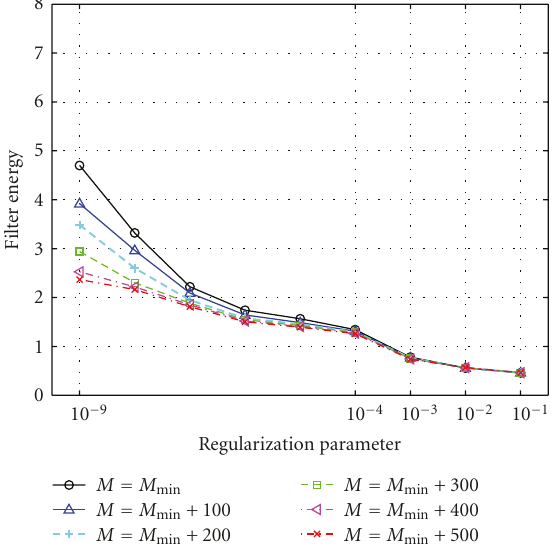
Figure 7: Filter energy as a function of regularization parameter and filter length (modeling delay is fixed at d =